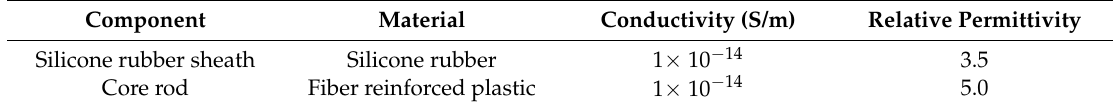
Table 1. Electrical parameter of material.